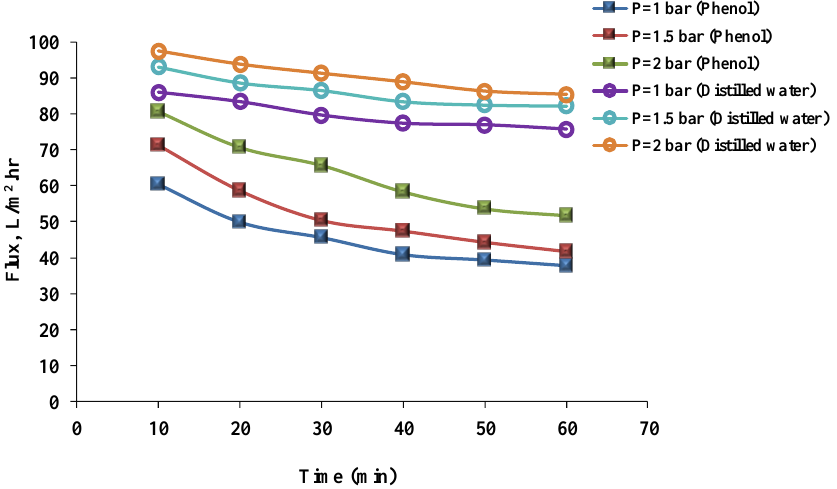
Figure 6. Phenol solution and distilled water’s fluxes with time for a hydrophilic membrane at different pressures (phenol concentration = 50 mg/L, temperature = 30 °C).